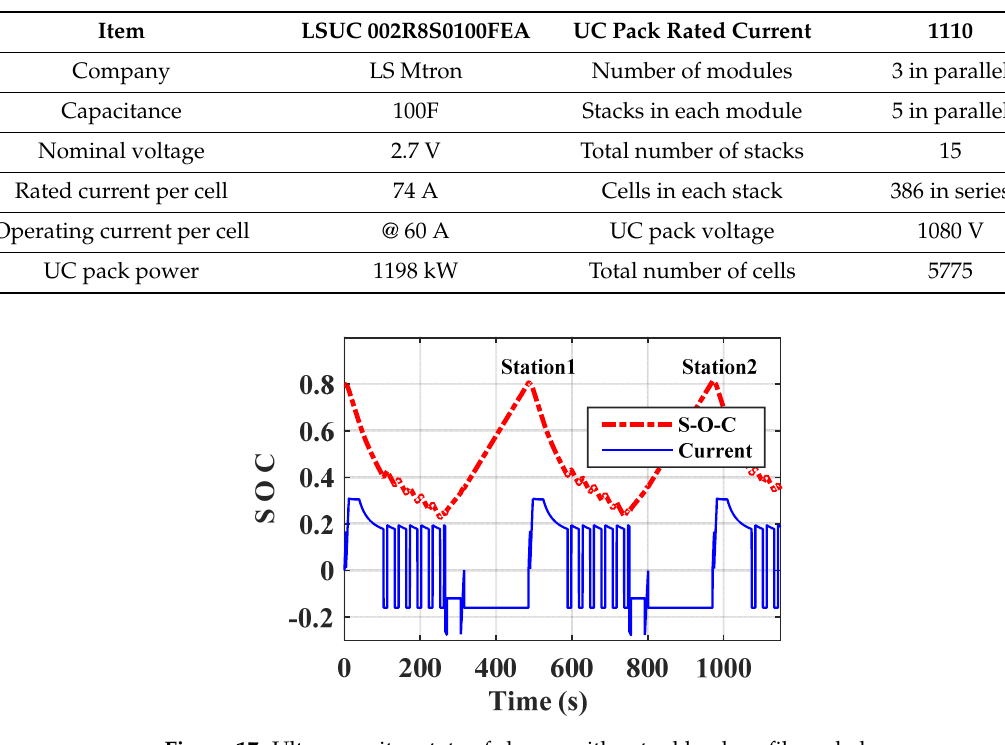
Table 3. Configuration and specification of UC for hybridization with FC.